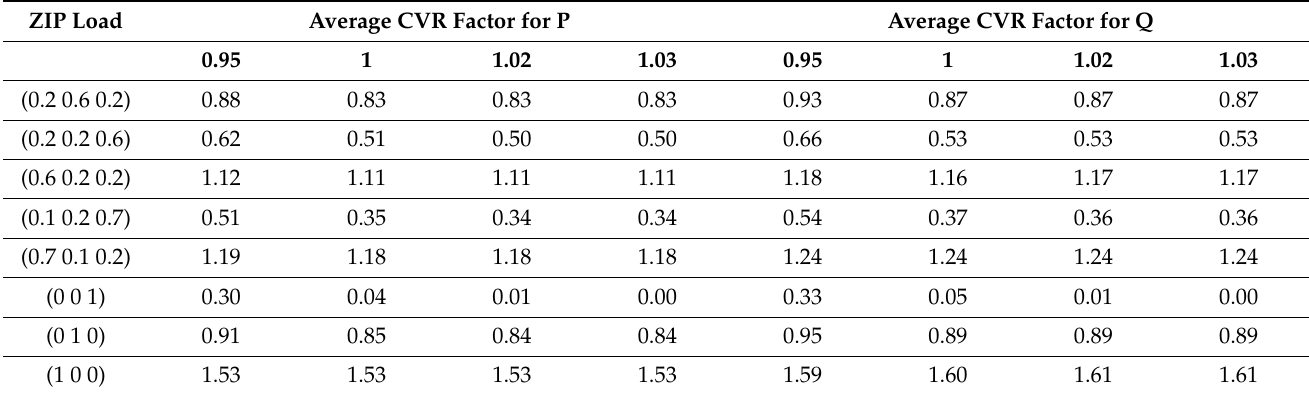
Table 3. Average CVR factor obtained using power captured at load for case 1.